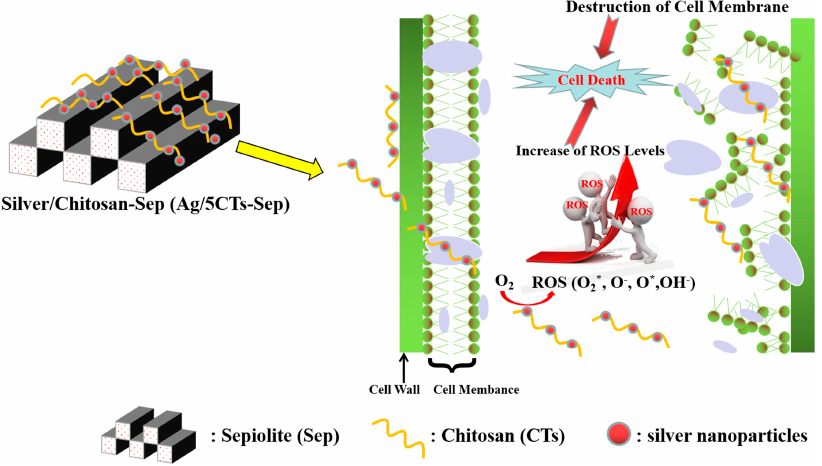
Figure 6. The possible synthetic and antifungal mechanisms of Ag/5CTs-Sep. Adapted from [137]. The antibacterial activity of organic–inorganic composite based on a sepiolite–chitosan– zinc system was tested against E. coli and S. aureus and evaluated by the disk diffusion method. The composites were synthesized via different combination styles and named as chitosan–zinc oxide/sepiolite (CTs-ZnO/Sep), zinc oxide/chitosan–sepiolite (ZnO/CTs-Sep) and chitosan/zinc oxide–sepiolite (CTs/ZnO-Sep). The results showed that the sample presented different inhibition zone width against bacteria and that CTs- ZnO/Sep, ZnO/CTs-Sep and CTs/ZnO-Sep displayed better against S. aureus antibacterial activity than E. coli [138]. Biddeci et al. present a bio-nanocomposite film with both anti- oxidant and antimicrobial activities prepared by the filling of a pectin matrix with modi- fied halloysite nanotubes containing the essential peppermint oil (PO). The HNTs surfaces were functionalized with cucurbit[6]uril (CB [6]) molecules, then, a pectin + HNT/CB [6]